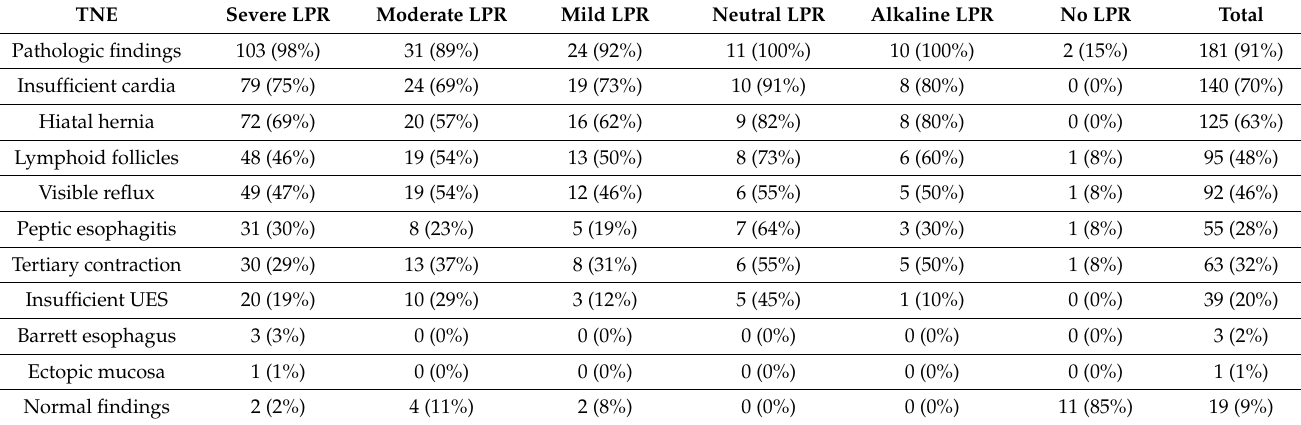
Table 2. Results of transnasal esophagoscopy in the assessment of laryngopharyngeal reflux ( n = 200).